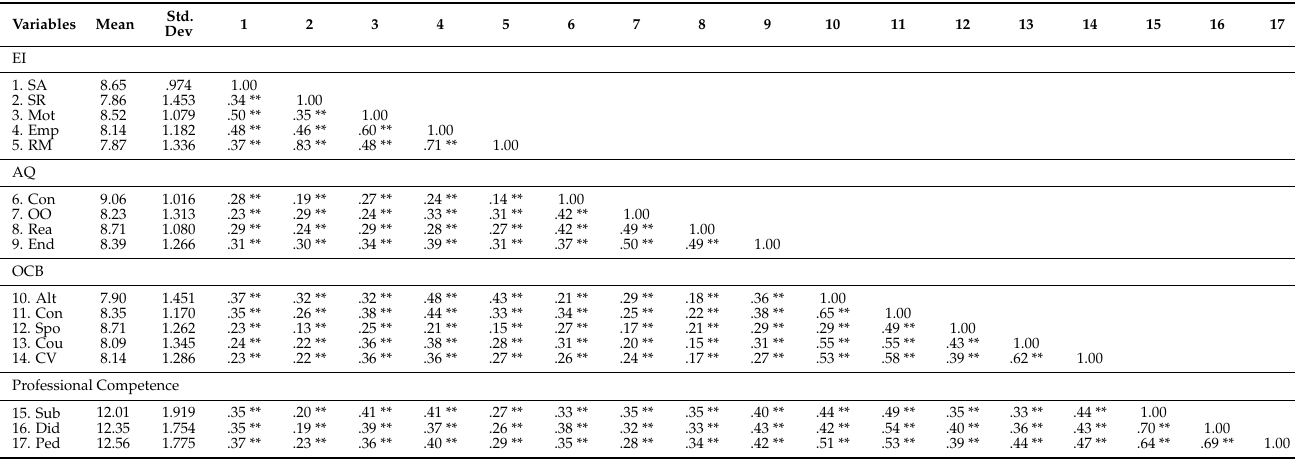
Table 2. Descriptive statistics and correlation